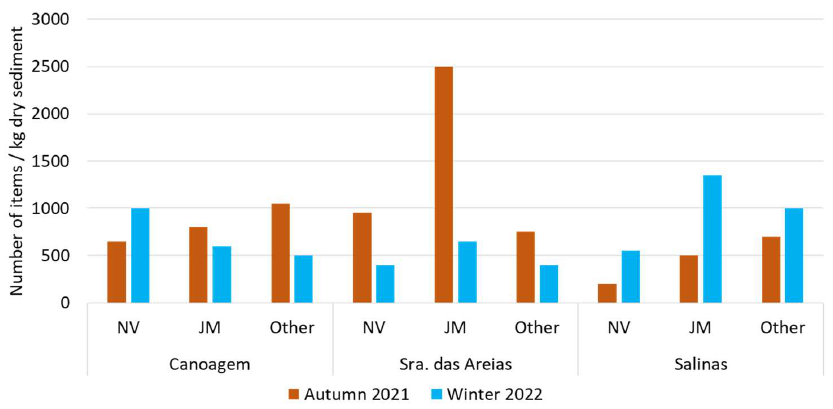
Figure 3. MP abundance in the Lima estuary sediments per sampling site (Canoagem, Sra. Areias, and Salinas, locations in Figure 1) and type of sediment (non-vegetated (NV) and vegetated by Juncus maritimus (JM) or by Phragmites australis (Other in Sra. das Areias and Salinas) or Spartina maritima (Other in Canoagem) in different sampling campaigns (autumn (November) 2021 and winter (February) 2022).